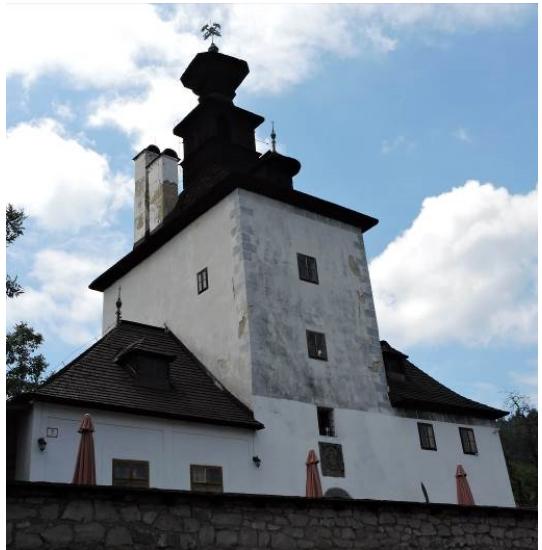
Figure 8. Picture of the Knocker in Banská Štiavnica